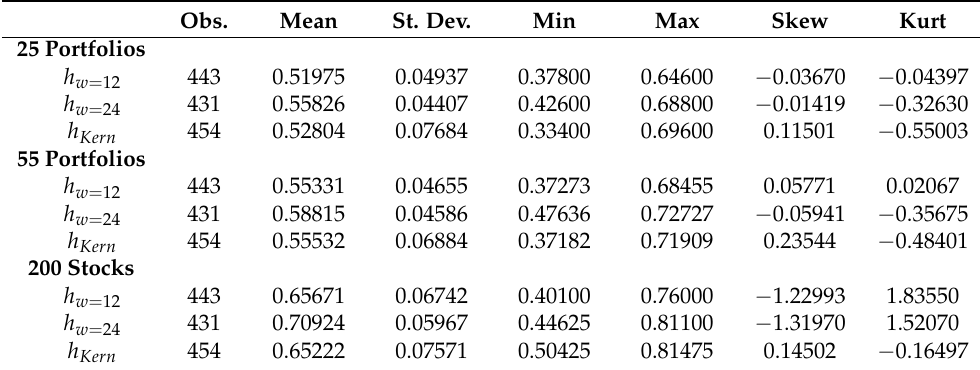
Table 1. Descriptive statistics for the optimal bandwidth parameter. Obs. Mean St. Dev. Min Max Skew Kurt 25